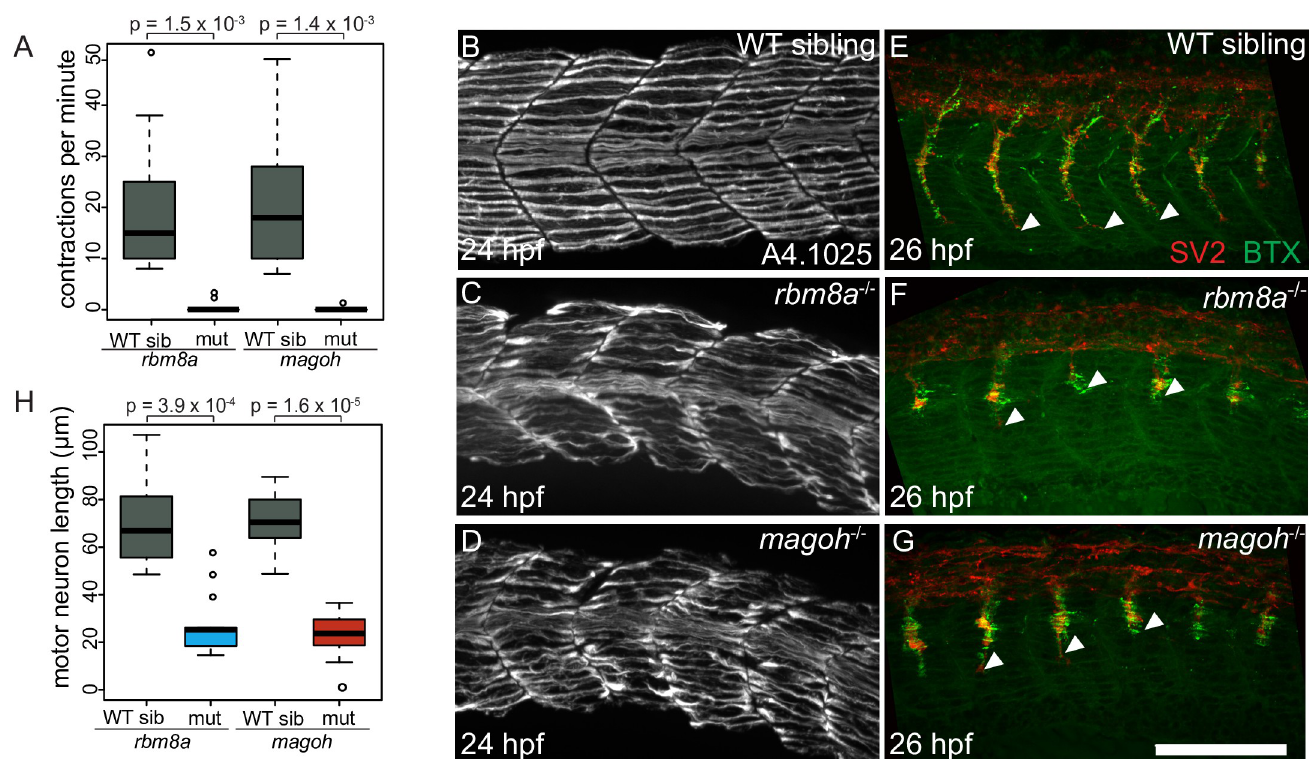
Fig 3. EJC mutant embryos are paralyzed, have disorganized muscles and stunted motor axons. A. Boxplots showing the number of spontaneous contractions per minute measured for the EJC mutant embryos and WT siblings at 24 hpf as indicated on the x-axis. Welch’s t-test p-values are indicated at the top. B-D. Immunofluorescence images showing Myh1 expression in somites 10–14 of WT sibling (B) rbm8a mutant (C) and magoh (D) mutant embryos. Antibody used was anti-A4.1025 (see methods) (N = 10 embryos/genotype). E-G. Merged confocal images of somites 12–16 in WT siblings (E) rbm8a (F) and magoh (G) mutant embryos showing immunofluorescence detection of motor neurons (anti-SV2; red) and acetylcholine receptors ( α -Bungarotoxin; green). Neuro-muscular junctions in the merged image appear yellow. White arrowheads point to the end of the motor neuron. Scale bar in G is 100 nm. H. Boxplots showing the quantification of motor axon length in somites 12–15 of wild-type sibling, rbm8a mutant, and magoh mutant embryos (N = 4 embryos/genotype and 4 neurons/ embryo). Welch’s t-test p-values are at the top.